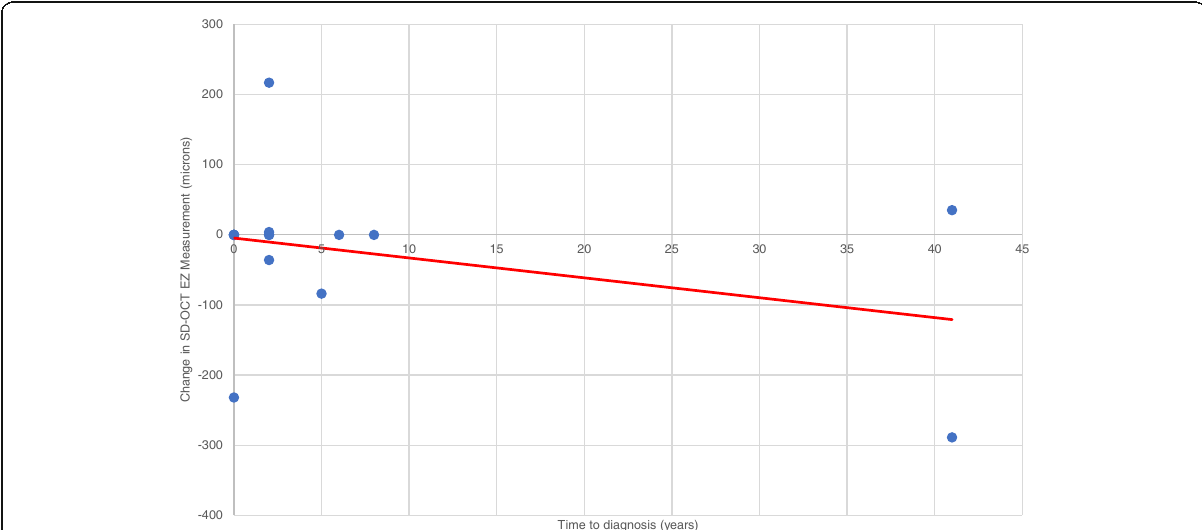
Fig. 7 There is a slight trend of decline in SD-OCT EZ horizontal extent measurement as there is an increase in the time from onset of symptoms to formal diagnosis ( R 2 = .132, p =